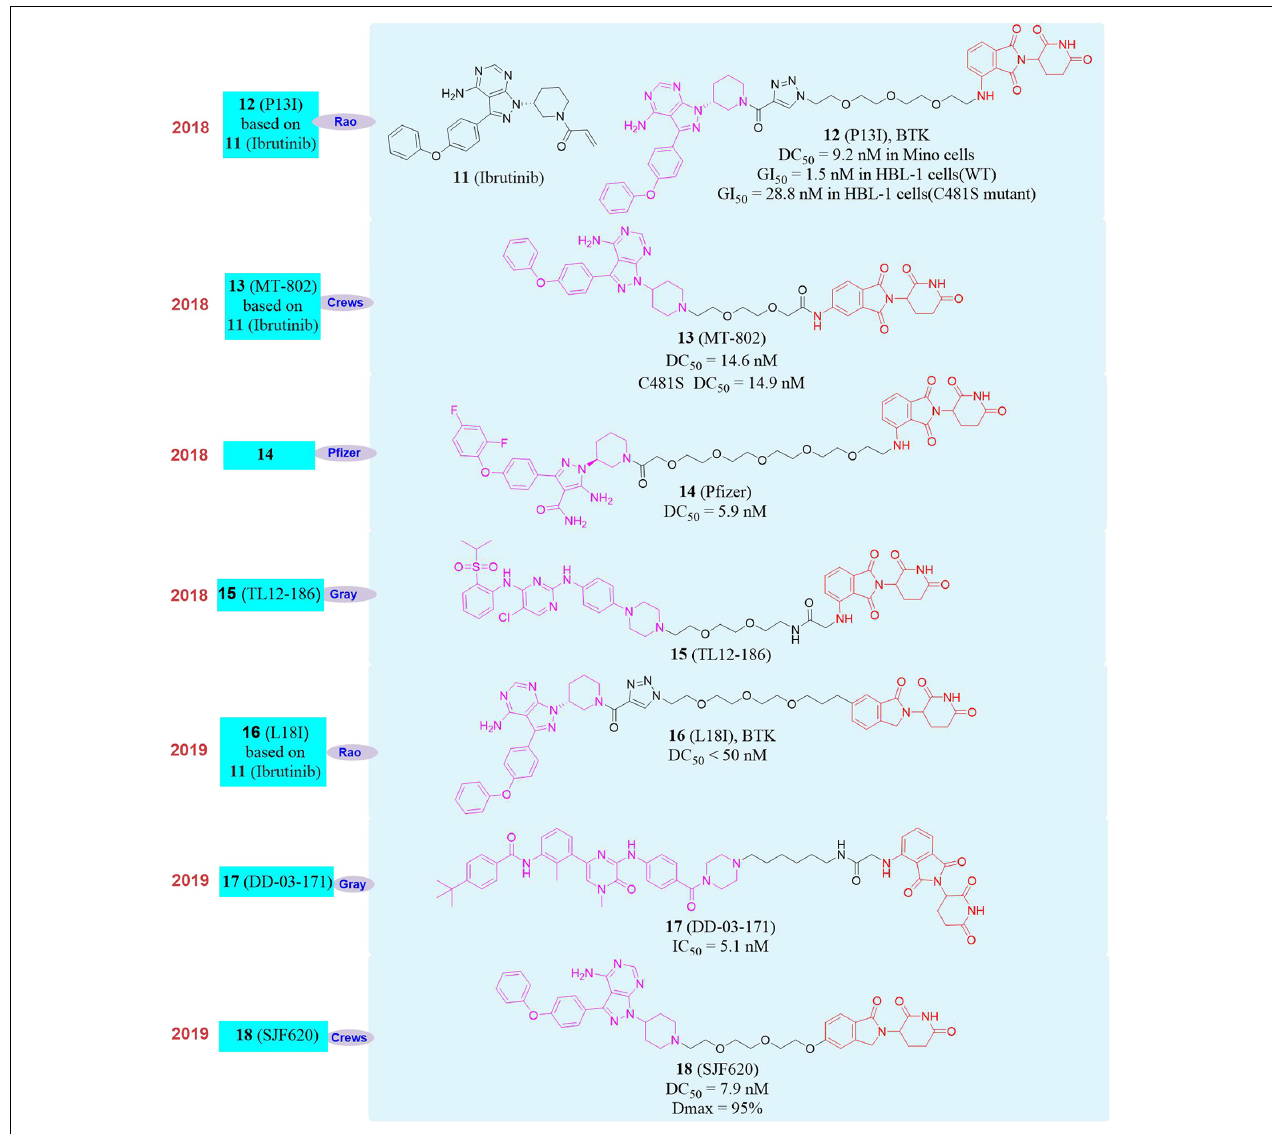
FIGURE 5 | Structures of BTK inhibitor and